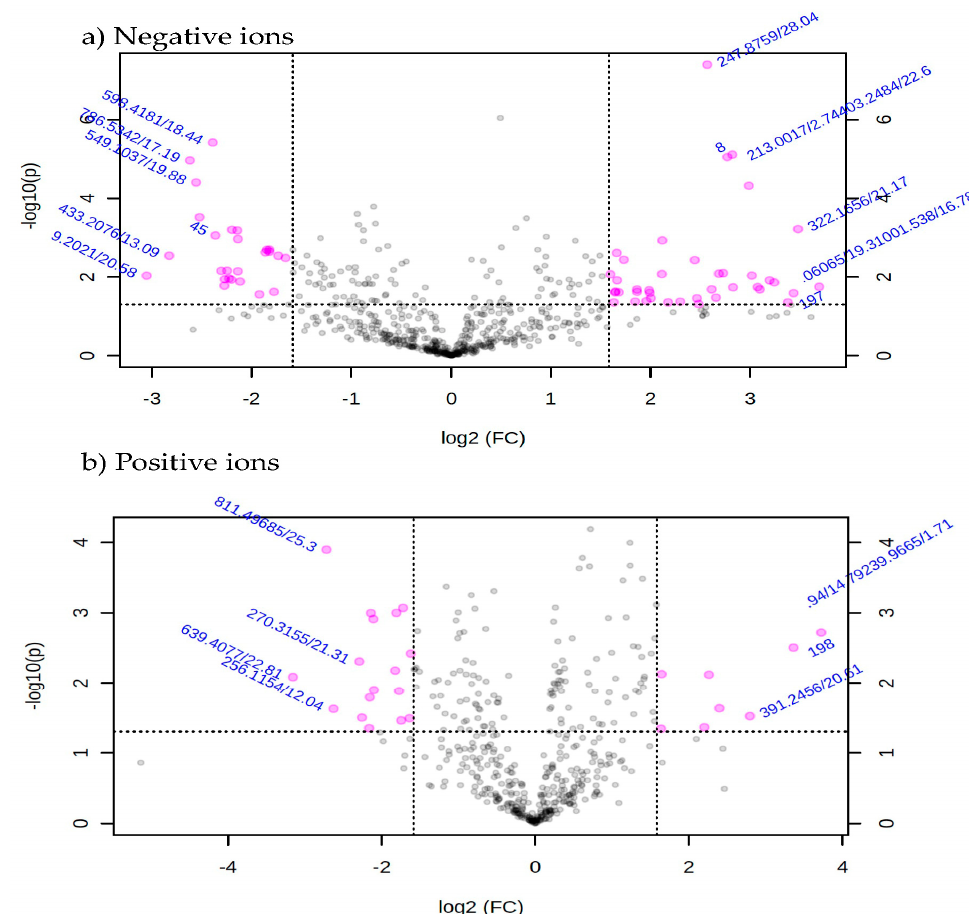
Figure 10. Volcano plot with fold change threshold (x) 3 and t -tests threshold (y) 0.05 principal components (PCs) in both ion modes of extracted samples; negative ion mode ( a ) and positive ion mode ( b ) groups. The pink circles represent features above the threshold.